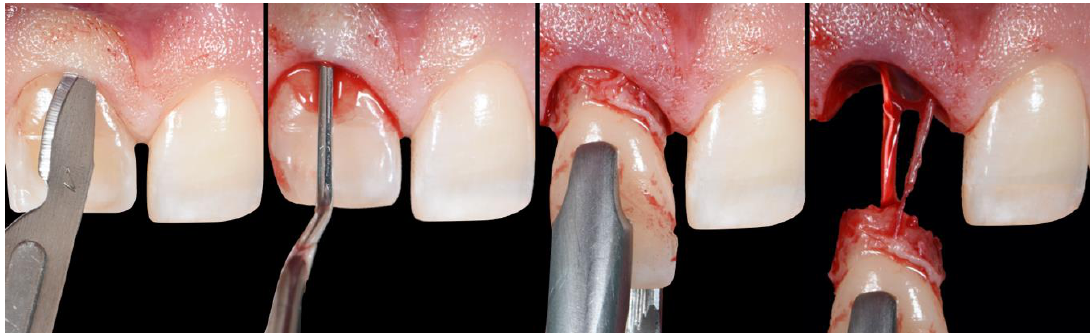
Figure 4. Atraumatic extraction of affected tooth with the use of periotomes and generation of partial thickness pouch flap with a